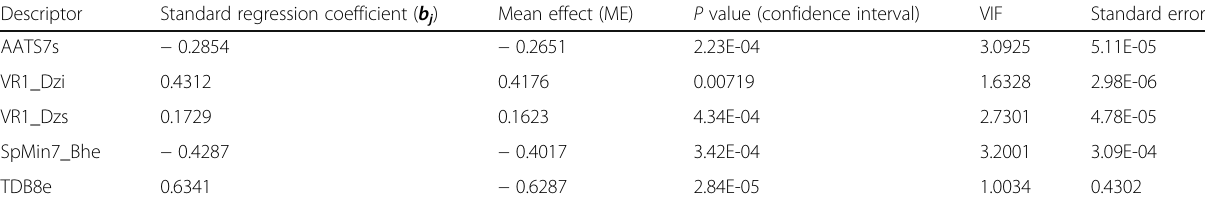
Table 3 Statistical analysis and validation of descriptors model